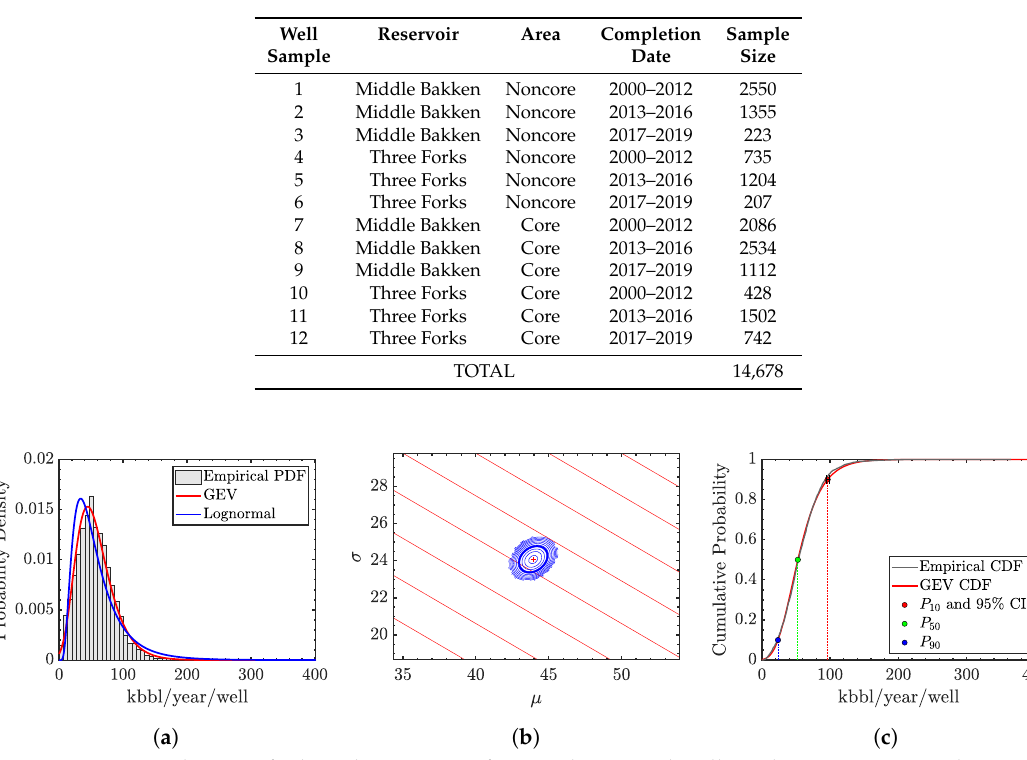
Table 1. Static regions for the Bakken shale play.